Question: Express in one sentence what the figure is showing.
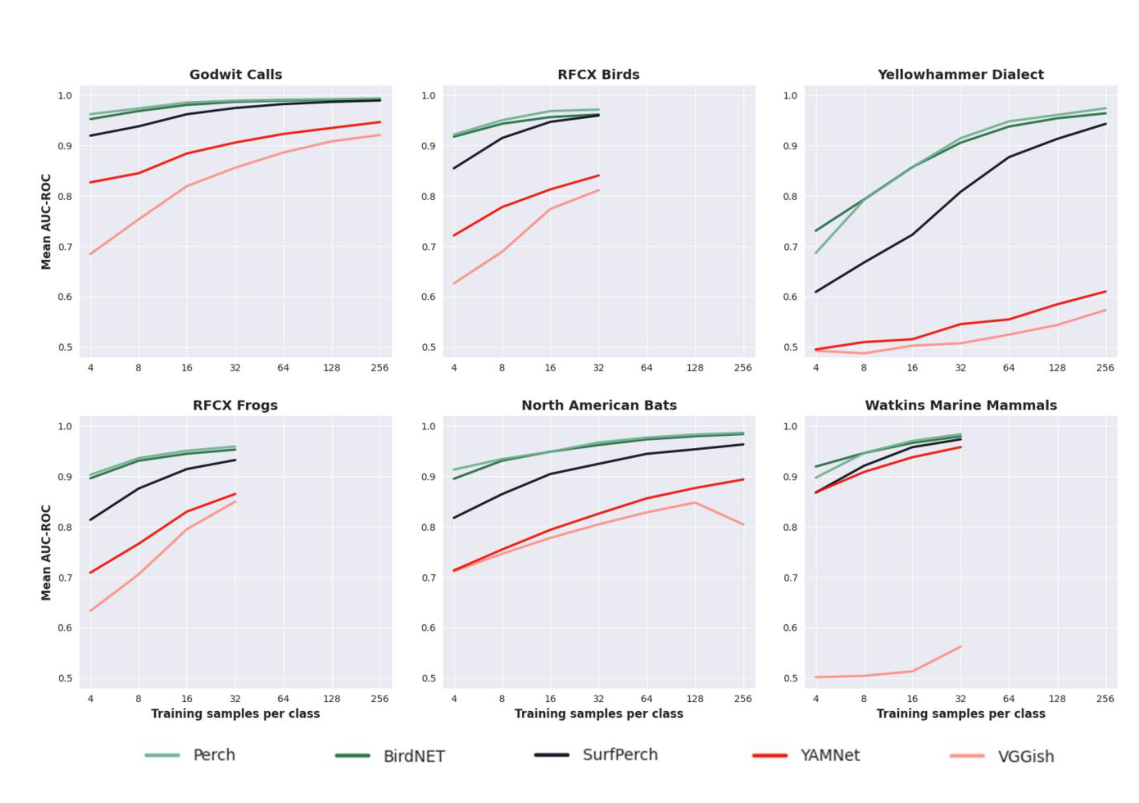
Answer: Mean AUC-ROC scores reported from transfer learning evaluation of each model on six novel  bioacoustic datasets. Each model and training sample per class count combination were repeated  across ten random seeds.